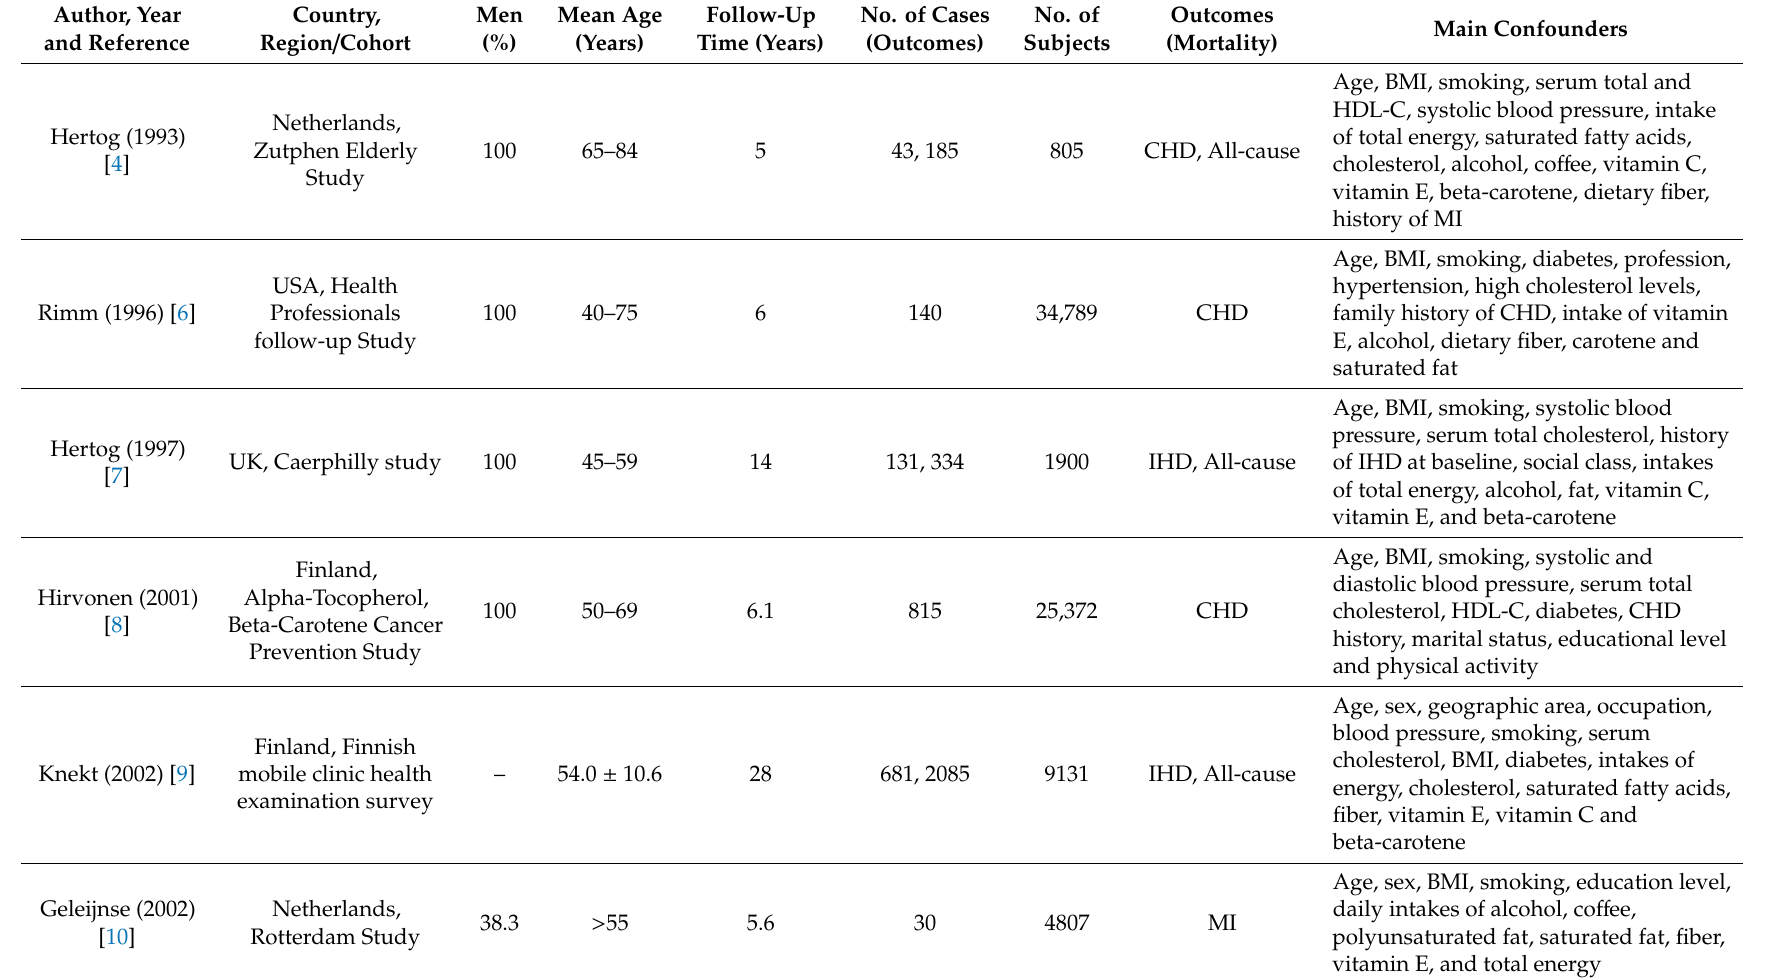
Table 1. Characteristics of the 16 prospective cohort studies included in the